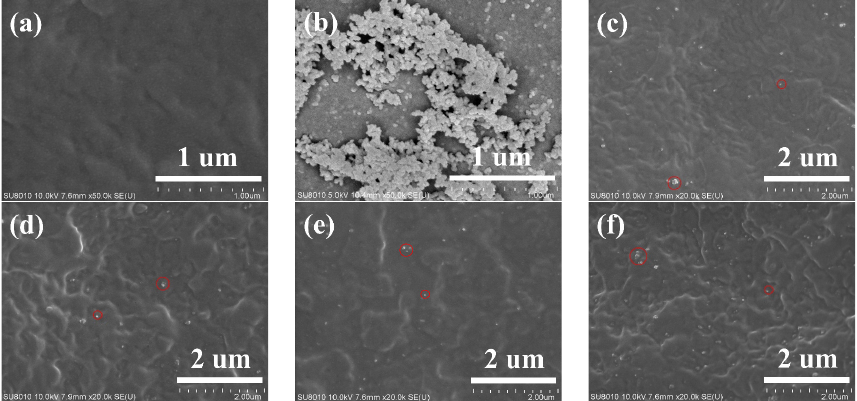
Figure 3. SEM images of composite with different SiO 2 contents: ( a ) PA11, ( b ) SiO 2 , ( c ) PA11/0.5% SiO 2 , ( d ) PA11/1.0% SiO 2 , ( e ) PA11/1.5% SiO 2 , ( f ) PA11/2.0% SiO 2.